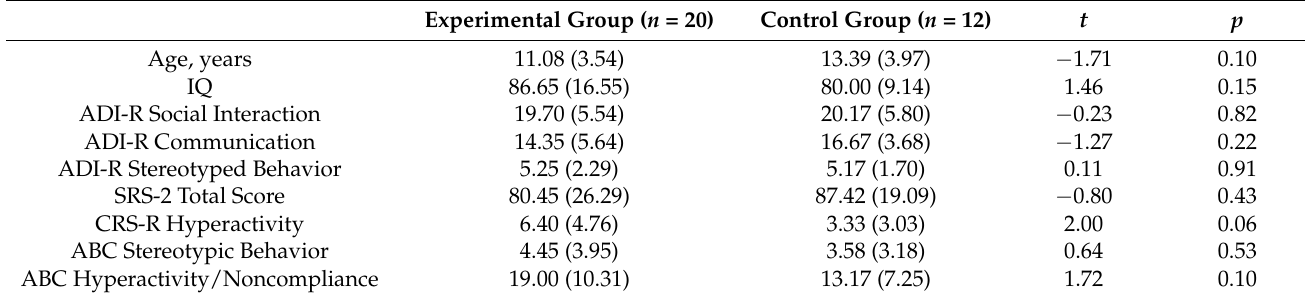
Table 1. Demographic and clinical characteristics of children with ASD in the experimental and control group at the baseline. Experimental Group ( n =